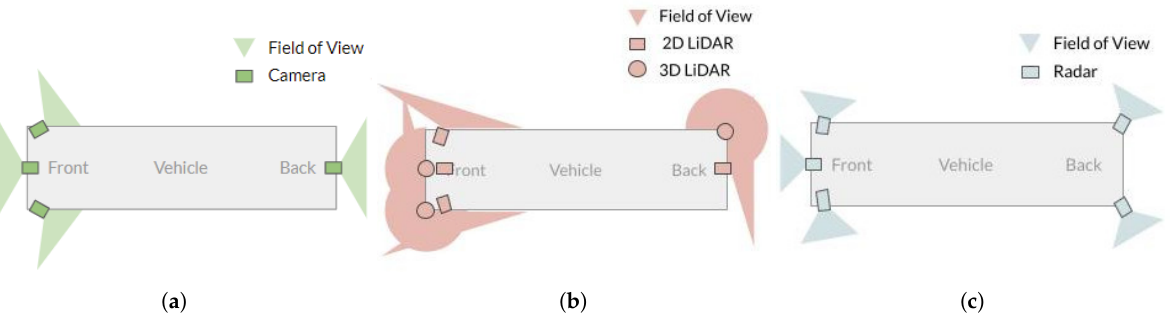
Figure 3. Sensor configurations of an autonomous bus (Top View). The labels describe each sensor’s field of view and placement as well. Further discussion of the sensors used is in Section 3. ( a ) Camera configuration. ( b ) LiDAR configuration. ( c ) Radar